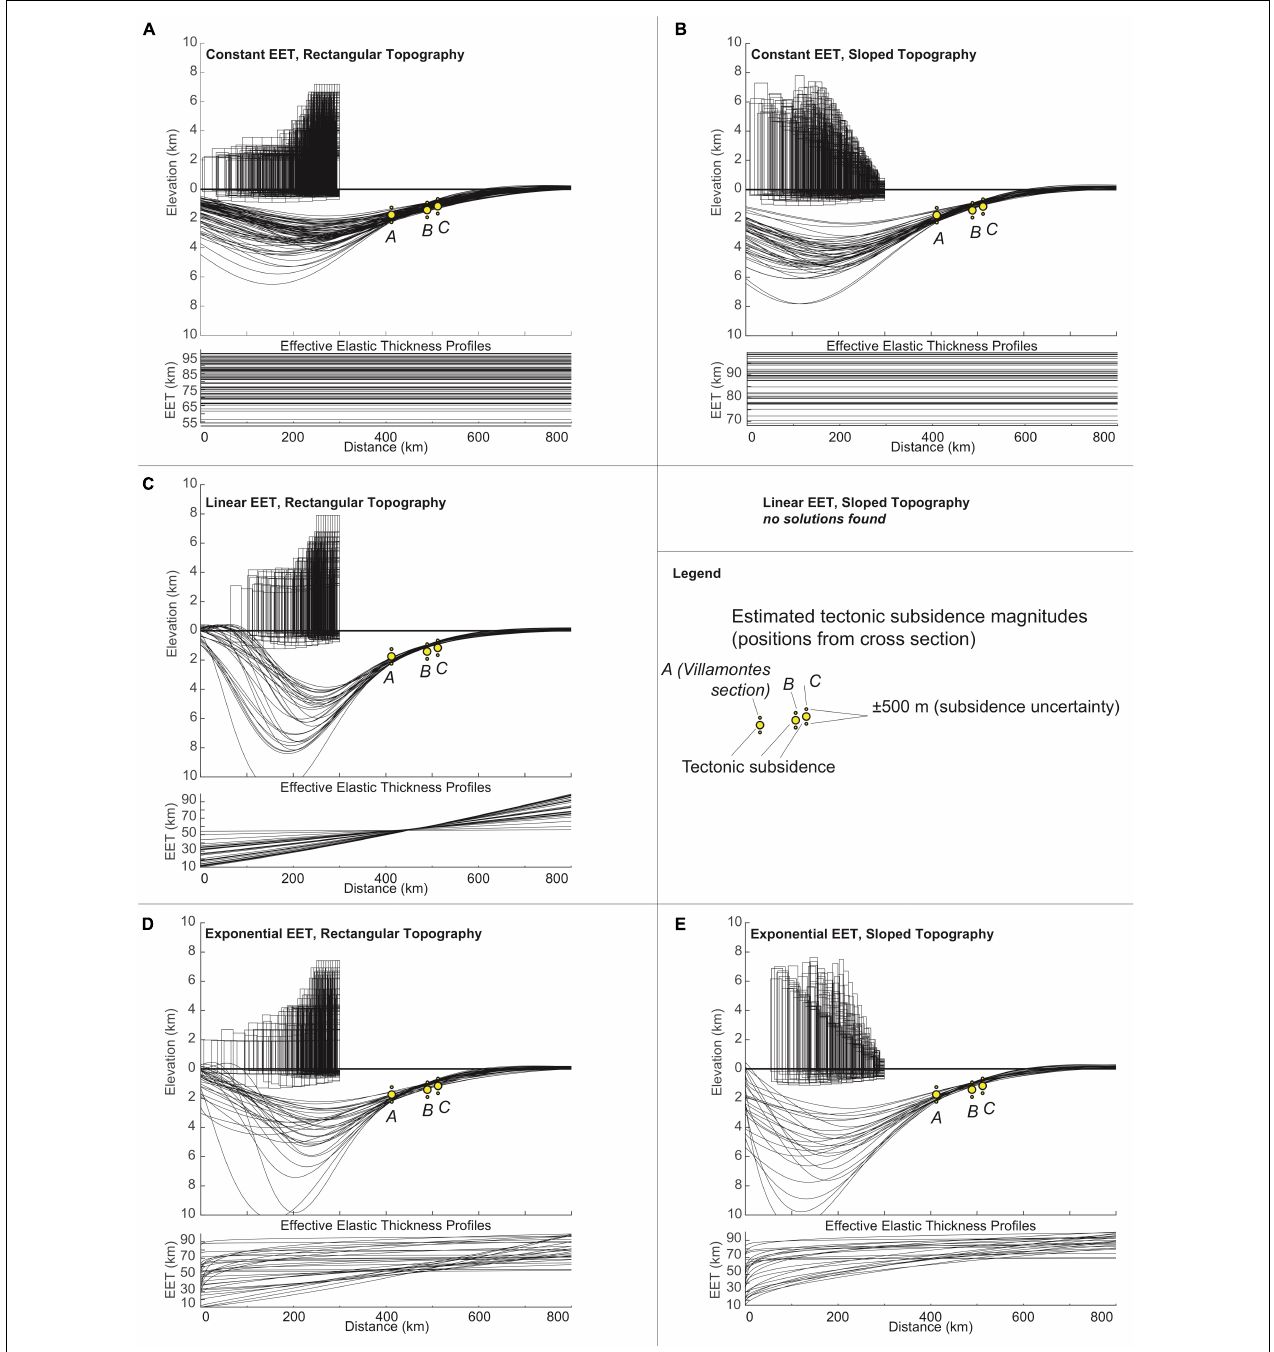
FIGURE 4 | Results from flexural modeling. Parts (A,B) show results from linear effective elastic thickness, (C) shows linearly changing effective elastic thickness, and parts (D,E) show exponentially changing effective elastic thickness. Panels on the left have rectangular topographic loads prescribed, while panels on the right have loads that slope toward the foreland. The positions of the sections at Villamontes, B, and C are situated at the same distance measured from the thrust front at 8 Ma in Figure 3 .